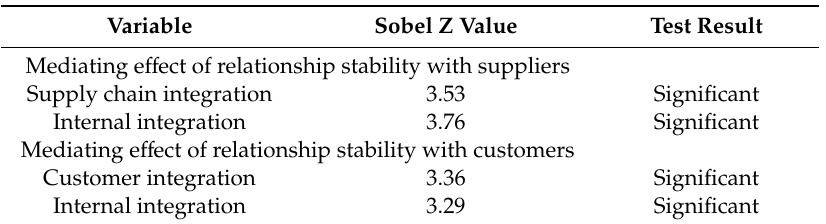
Table 7. Sobel analysis